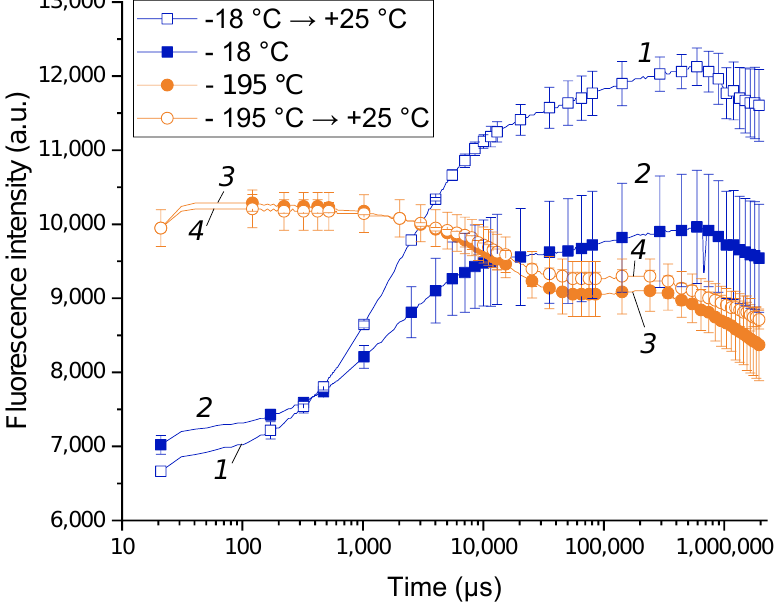
Figure 1. Difference between the chlorophyll a fluorescence induction curves of live apple tree shoots (1, 2) and those irreversibly damaged by liquid nitrogen freezing (3, 4). Typical OJIP curves of the apple tree shoots maintained at − 18 ◦ C (2) and subsequently warmed up to 25 ◦ C (1) as well the OJIP curves of the apple tree shoots frozen in liquid nitrogen ( − 195 ◦ C; 3) and subsequently warmed up to 25 ◦ C (4).